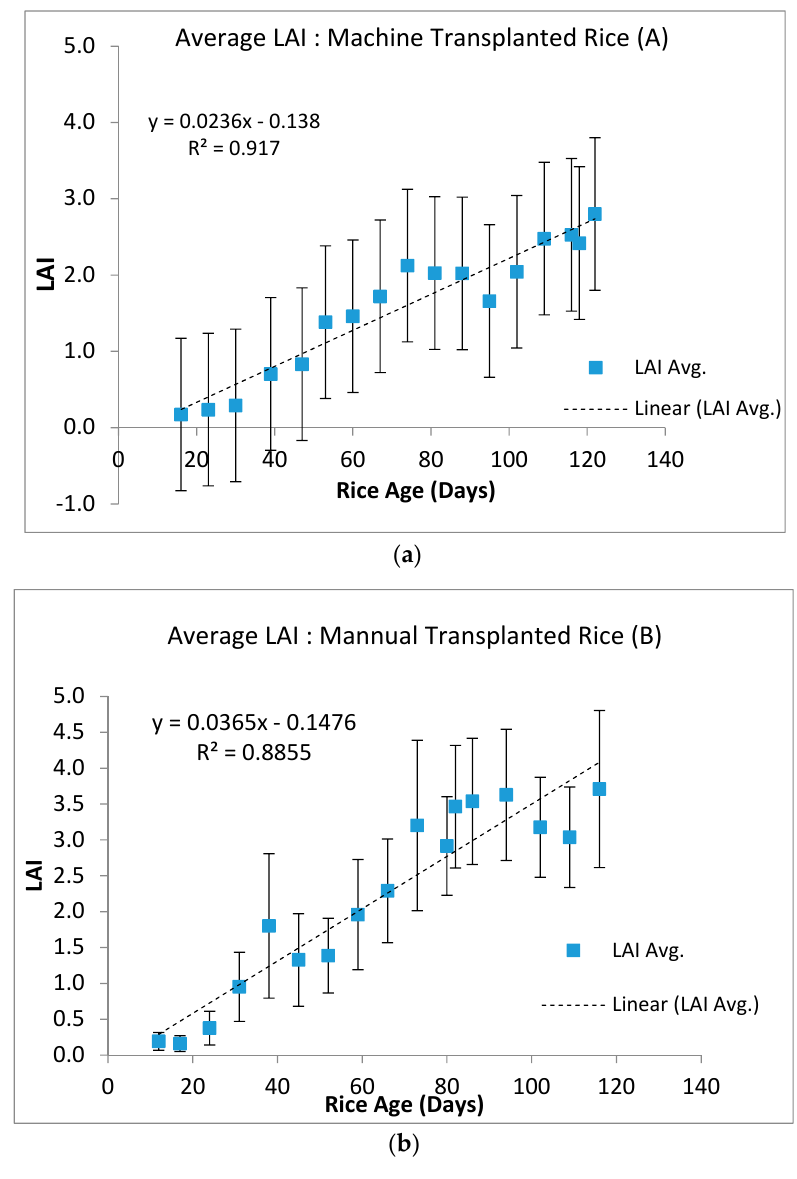
Figure 4. The relationship between the measured average LAI and rice age for sample LAI mean of rice. Graph ( a ) was presented the relationship of rice in groups A and graph ( b ) for rice group B; error bar represents standard deviation of field measurement.